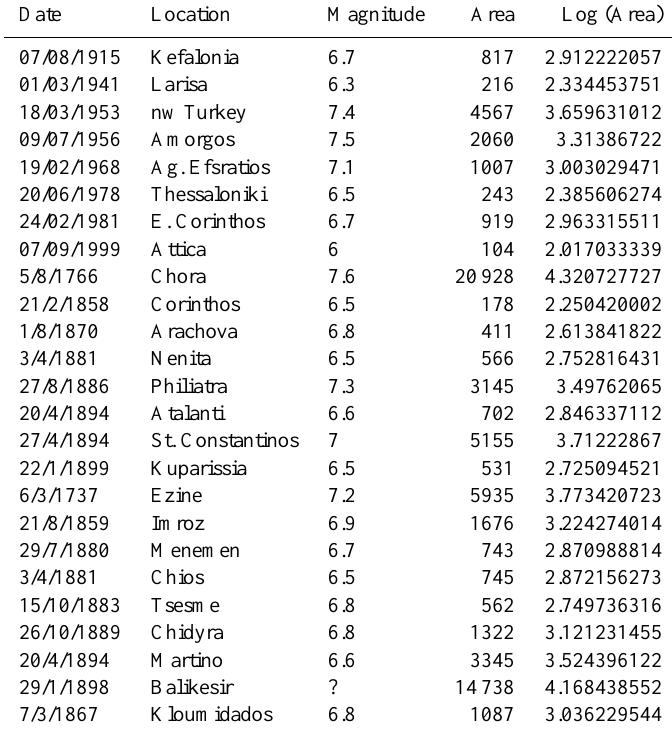
Table 1. Earthquake data and calculated isoseismal areas for MMI = 6.